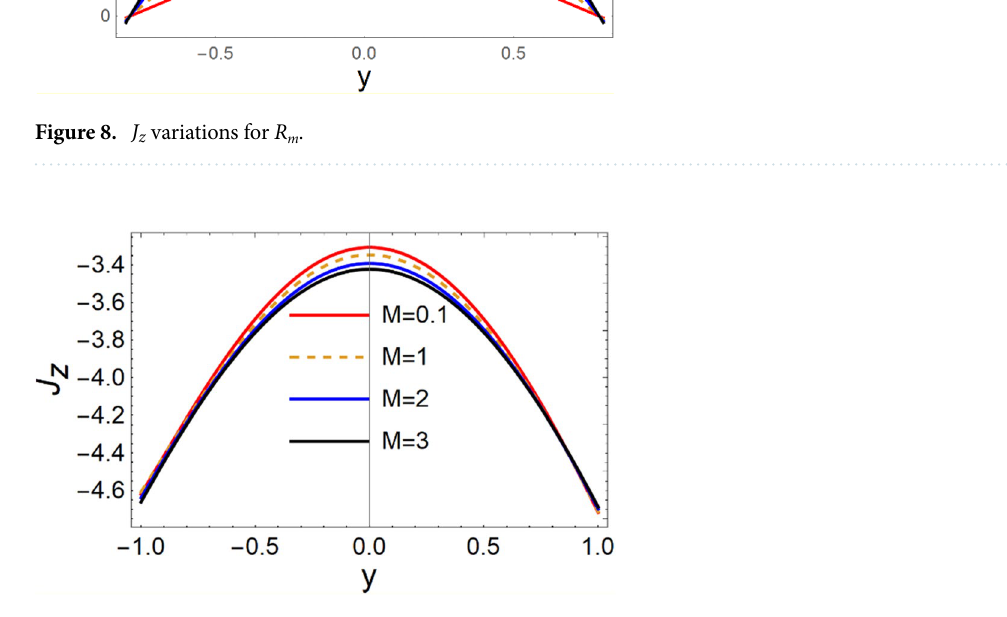
Figure 9. J z variations for